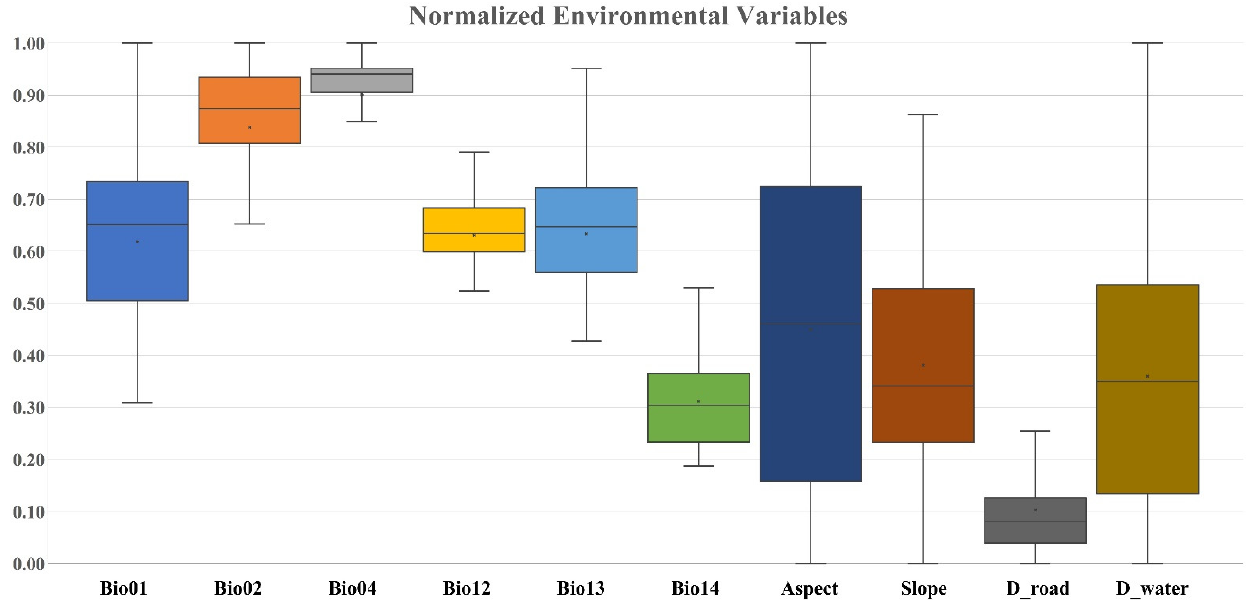
Figure 4. Bar plot showing the distribution of value of normalized environmental variables. Since the units and values of each environmental variable were different, they were normalized and expressed as one boxplot.